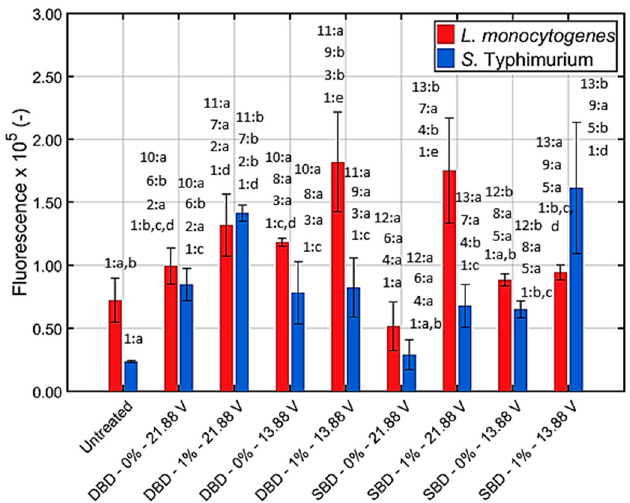
Figure 5. Fluorescence measurements (-) obtained following CAP and DCFH2-DA treatment of the Listeria monocytogenes and Salmonella Typhimurium model biofilms ( n = 3). For each species, significant differences between all examined conditions (ANOVA test 1), including the untreated control, have been indicated by means of a different small letter, with ‘a’ bearing the lowest value. The influence of the oxygen level (ANOVA tests 2–5), the electrode configuration (ANOVA tests 6–9), and the discharge power (ANOVA tests 10–13) have been indicated as well by means of a different small letter, with ‘a’ again bearing the lowest value. Separate ANOVA tests were performed for each biofilm forming species.